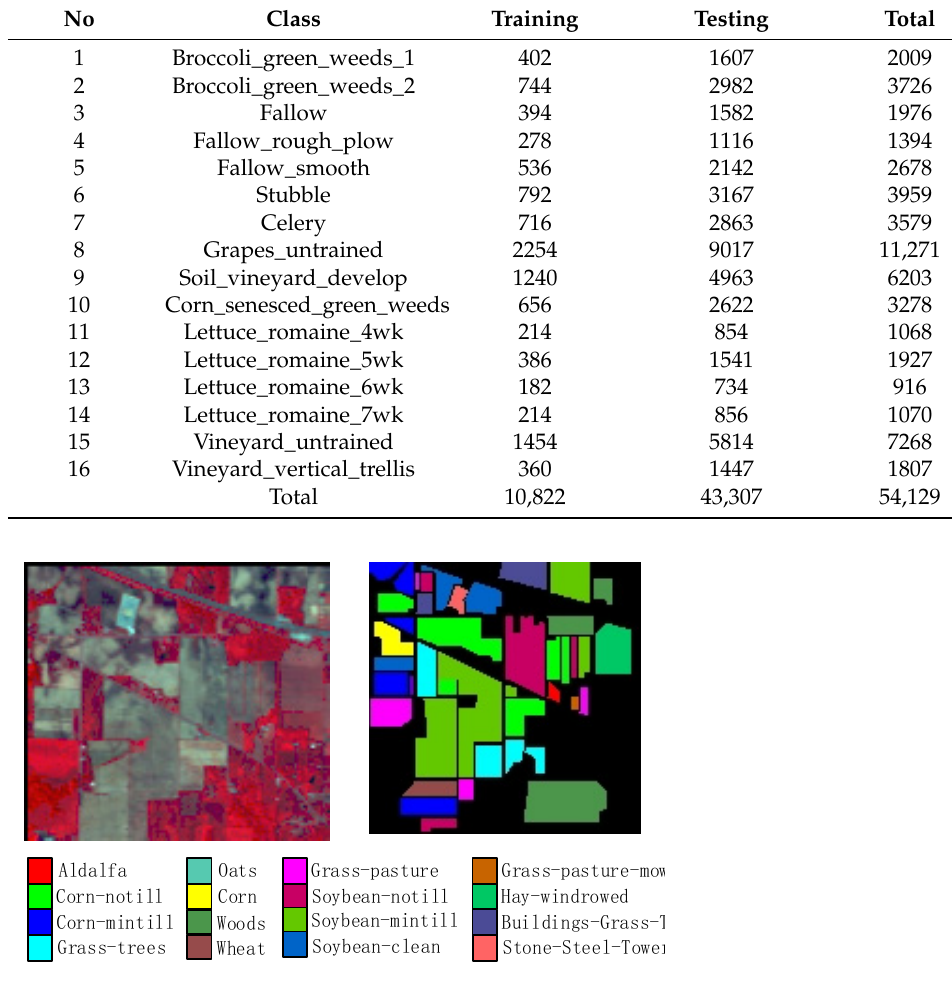
Figure 5. Salinas images: ( a ) pseudo-color image; ( b ) ground-truth labels. Table 2. Training and testing samples for the SA Dataset.